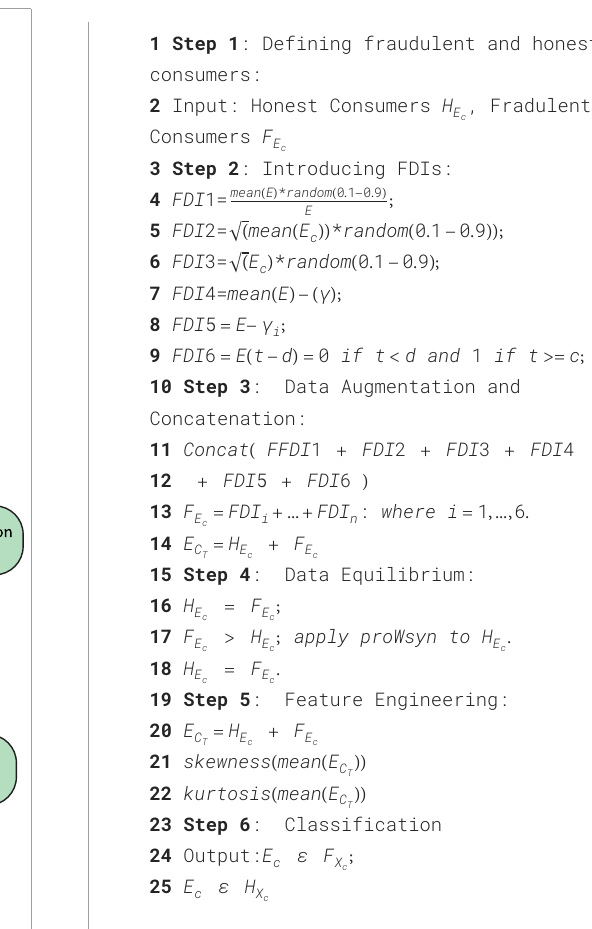
FIGURE 5 Working of flowchart.